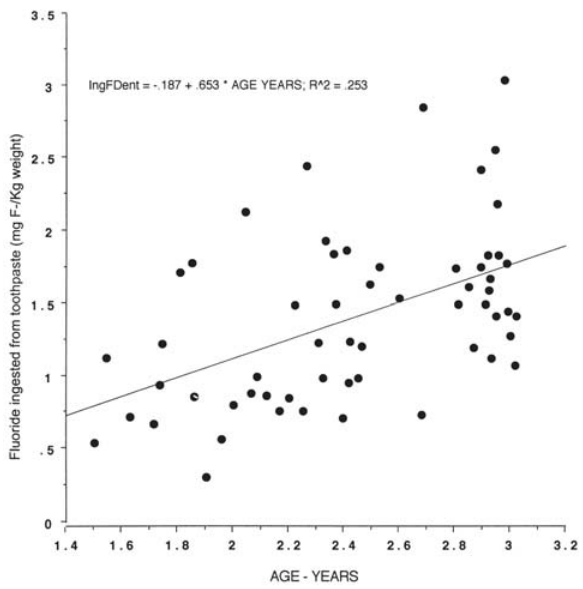
FIGURE 2- Relationship between age of children and fluoride